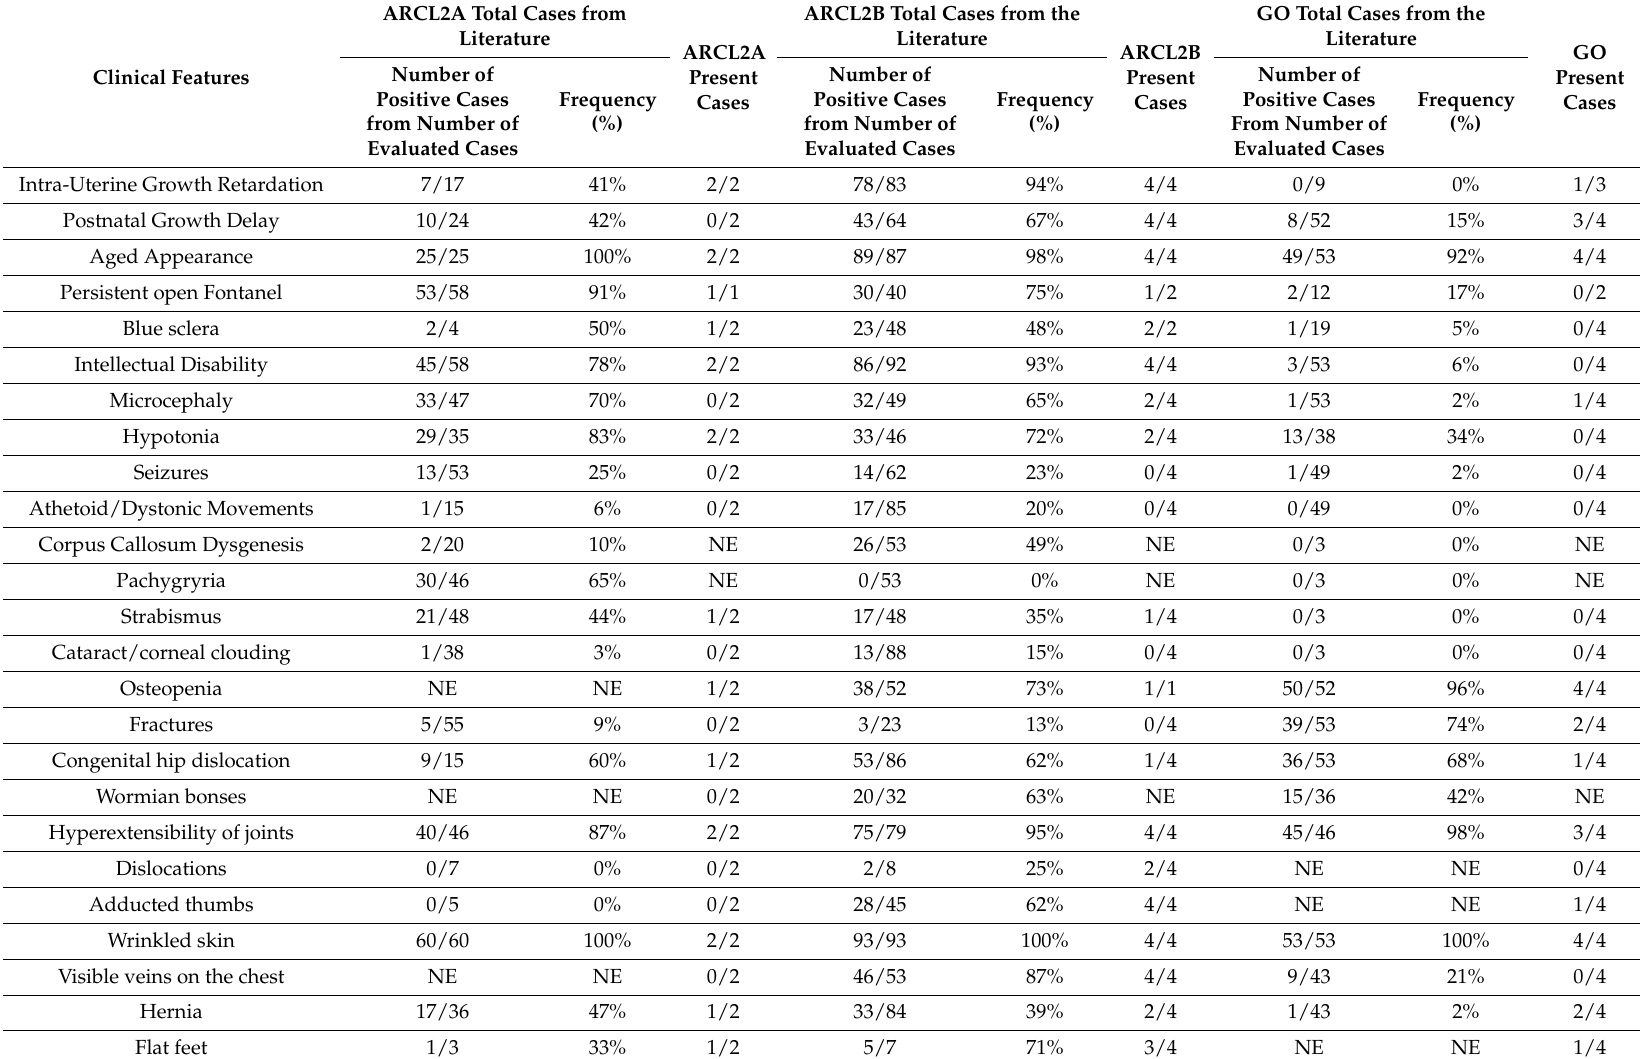
Table 2. Comparison of clinical features of cases with ARCL2A, ARCL2B, and GO in present cases and cases from the literature. NE, not